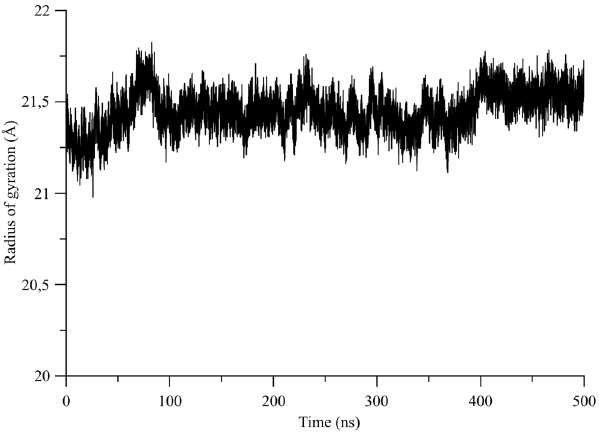
Fig. 2. Radius of gyration of the m OR structure along the 0.5 m s all-atom MD simulation.